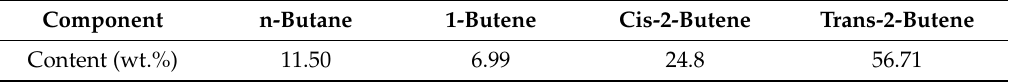
Table 5. Composition of feed